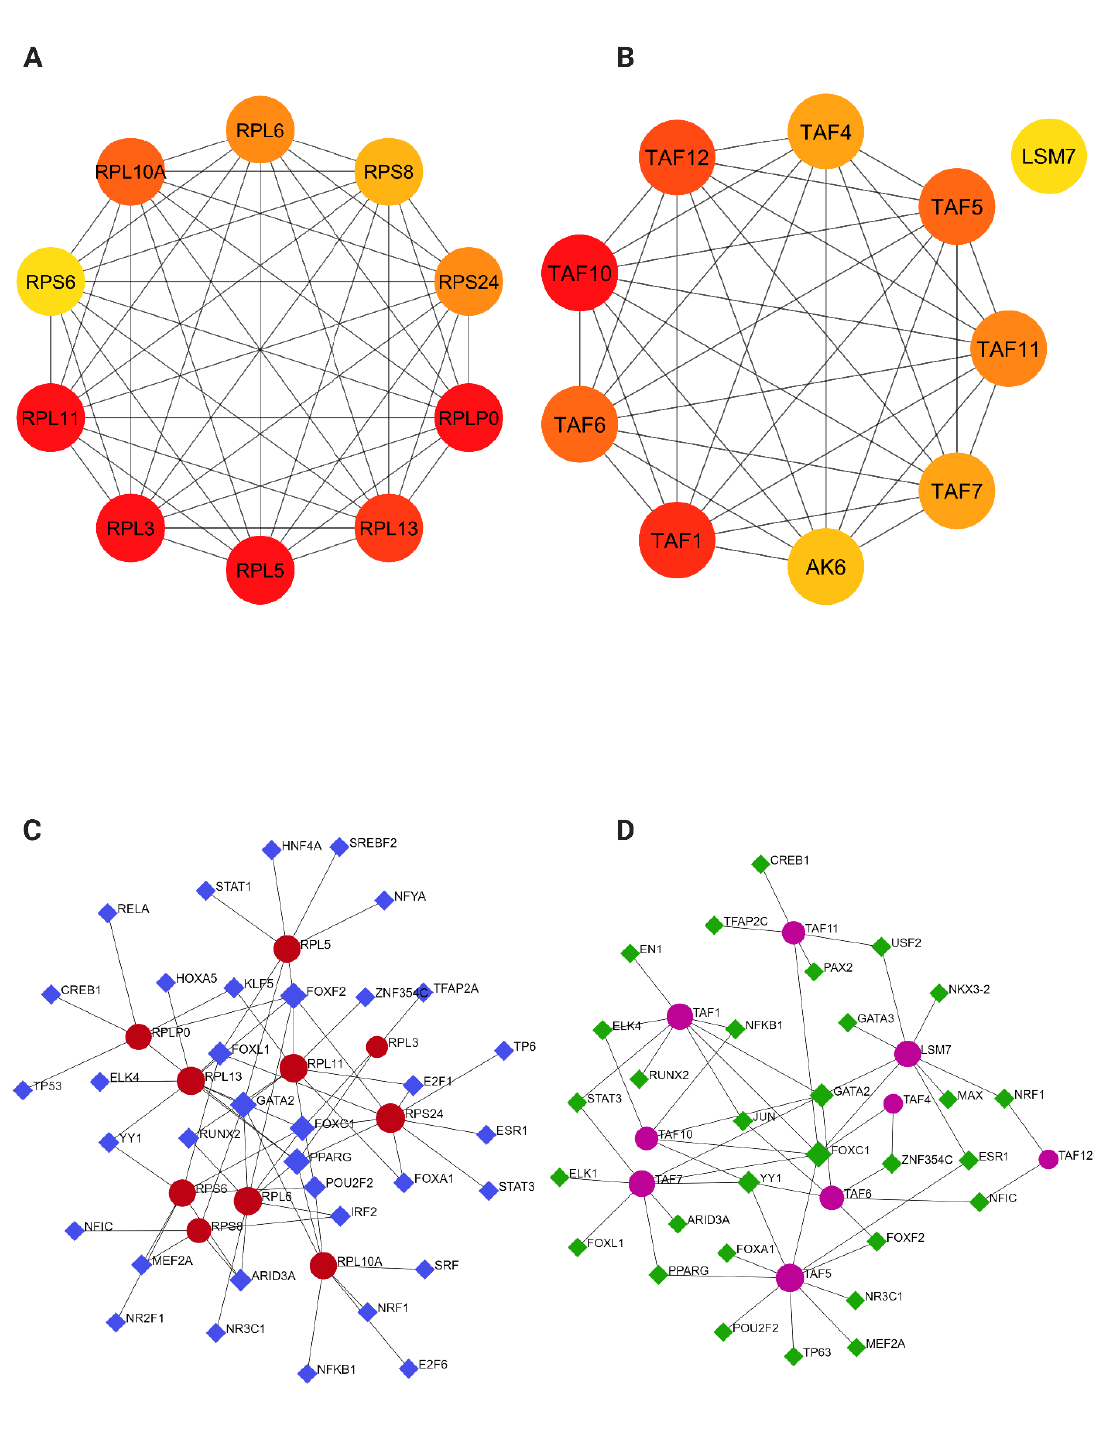
Figure 4. Integrated analysis on hub genes further highlighted one main pathway in SOD1- and TDP43 ALS. ( A ) Top 10 hub genes from SOD1- and ( B ) TDP43-ALS identified using the cytoHubba plugin (Cytoscape) among TDP43-ALS and SOD1-ALS datasets. The deeper the color of the node, the higher the level of significance at the PPI network. ( C ) The hub gene-transcription factor (TF) regulatory interaction networks in SOD1- and ( D ) TDP43-ALS datasets. Red and pink nodes stand for the hub gene and blue and green diamond stands for the transcription factor. On the other hand, using the cytoHubba plugin in Cytoscape [53], a total of 10 nodes were identified as hub genes from the overall PPI network of TDP43-ALS motor neurons ( TAF10 , TAF1 , TAF12 , TAF6 , TAF5 , TAF11 , TAF7 , TAF4 , AK6 , and LSM7 ) (Figure 4B).